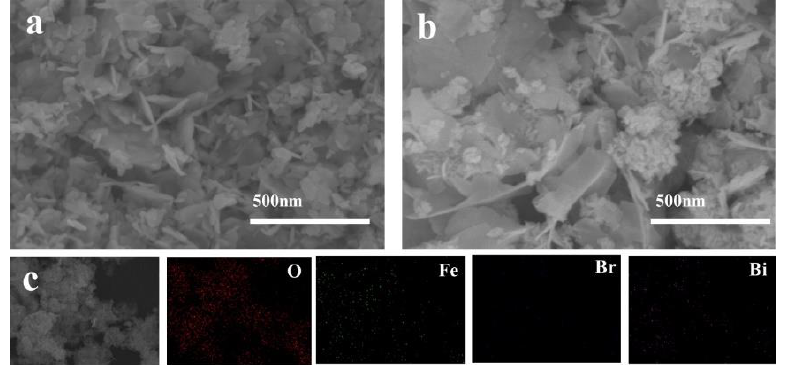
Figure 2. FESEM ( a , b ) of Bi 4 O 5 Br 2 and 5%Fe-Bi 4 O 5 Br 2 . ( c ) Element mapping image of 5%Fe-Bi 4 O 5 Br 2 .